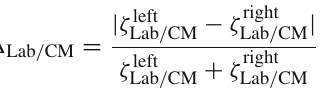
/ 3 ) c and ( R + 2 / 3 ) c respectively at 2 2